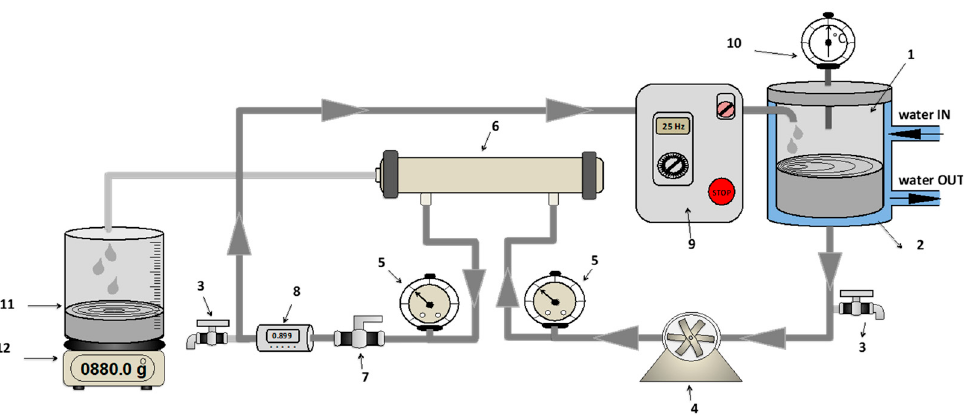
Figure 1. Schematic representation of reverse osmosis (RO) plant (1—feed tank; 2—cooling shell; 3—discharge tap; 4—feed pump; 5—manometers; 6—membrane module; 7—regulation valve; 8—digital flowmeter; 9—control panel; 10—thermometer; 11—permeate tank; 12—digital balance).